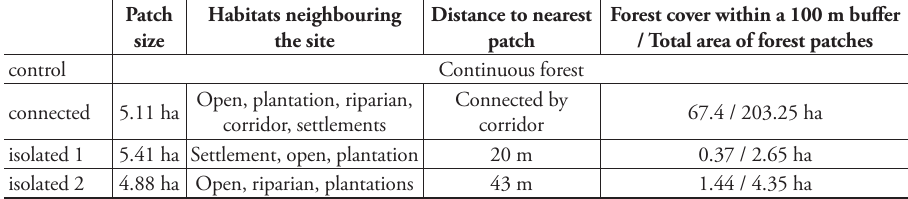
Table 1. Characterisation of the study sites. Habitats around each study site are ordered according to ranking of border-length. Forest cover within 100 m represents the area of forest within a buffer of that distance, whilst the total area of forest patches represents the total area of all patches that partly or fully occur within this